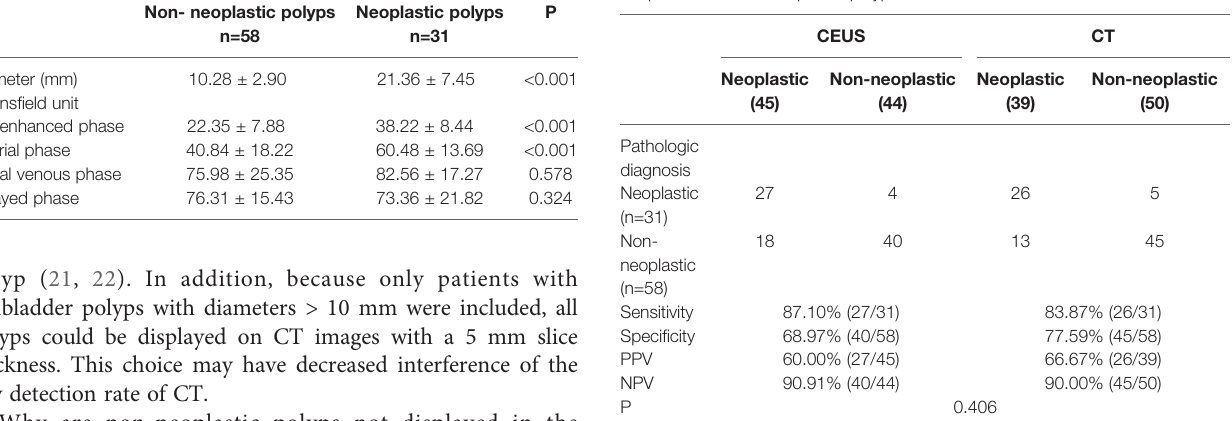
TABLE 5 | Comparison of the diagnostic accuracy of CEUS and CT in neoplastic and non-neoplastic polypoid lesions.